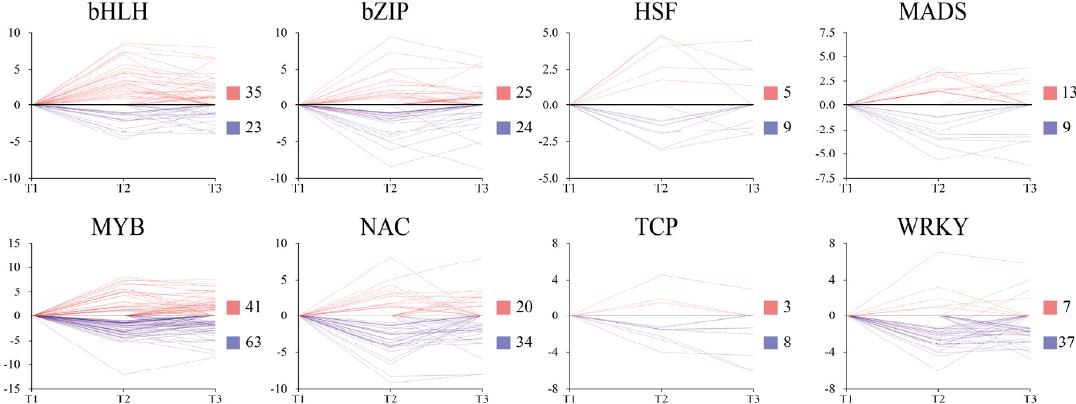
Figure 8. Expression patterns of different transcription factors during tuberization in ‘Tuershao’. Y-axis denotes log 2 (Foldchange). Red and blue squares represent up and downregulated genes, respectively.